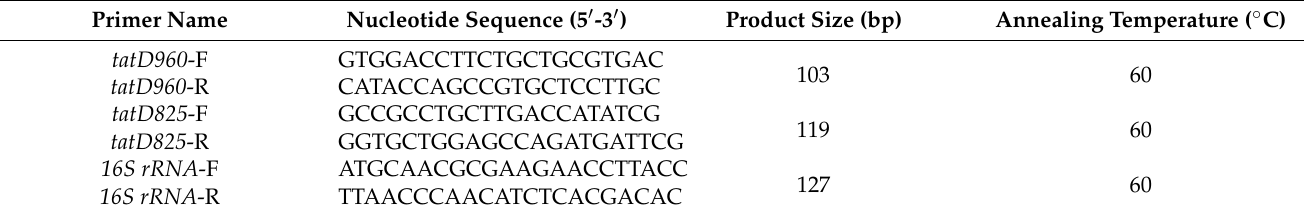
Table 1. Primer sequences for qPCR used in this